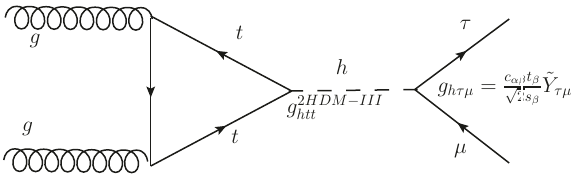
Figure 1 . Feynman diagram of the Higgs boson production via the gluon fusion mechanism with its subsequent decay into (cid:28)(cid:22) pair. The g 2HDM-III coupling can be consulted in eq. htt